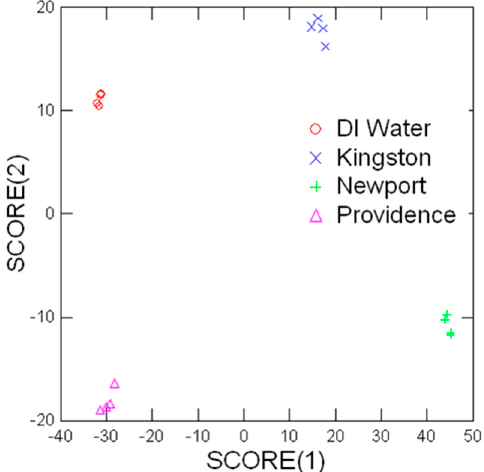
Figure 6. Array response patterns using linear discriminant analysis of fluorescence response signals of fluorophore 9 in undoped snow melt samples, with cyclodextrins as